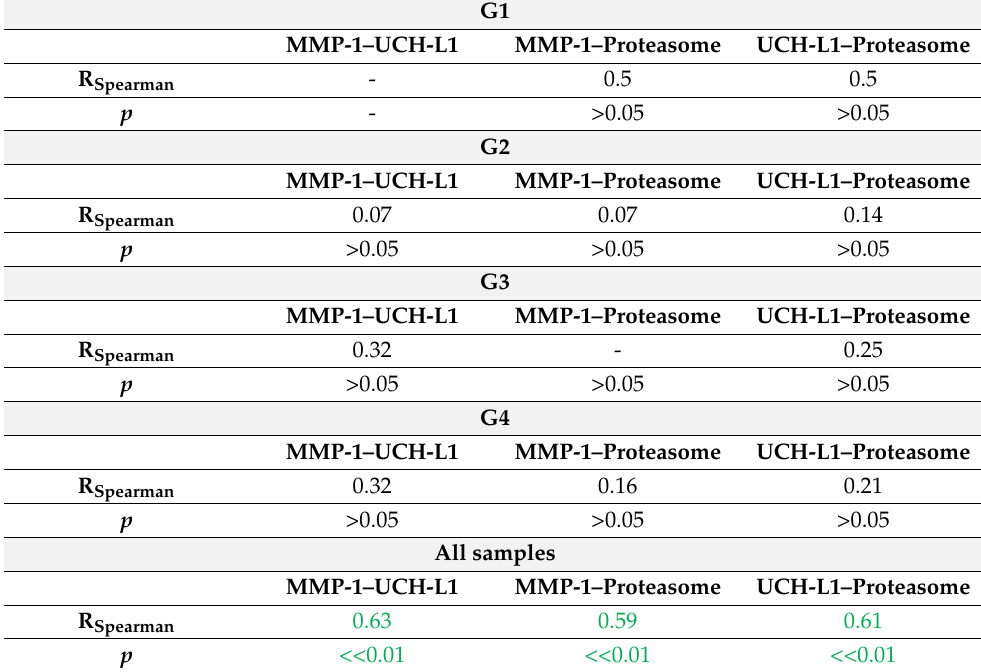
Table A5. Correlation analysis between